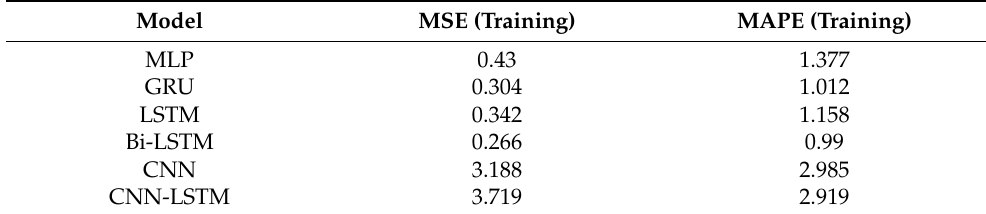
Table 9. The training results of the models using ExxonMobil data with six input features.